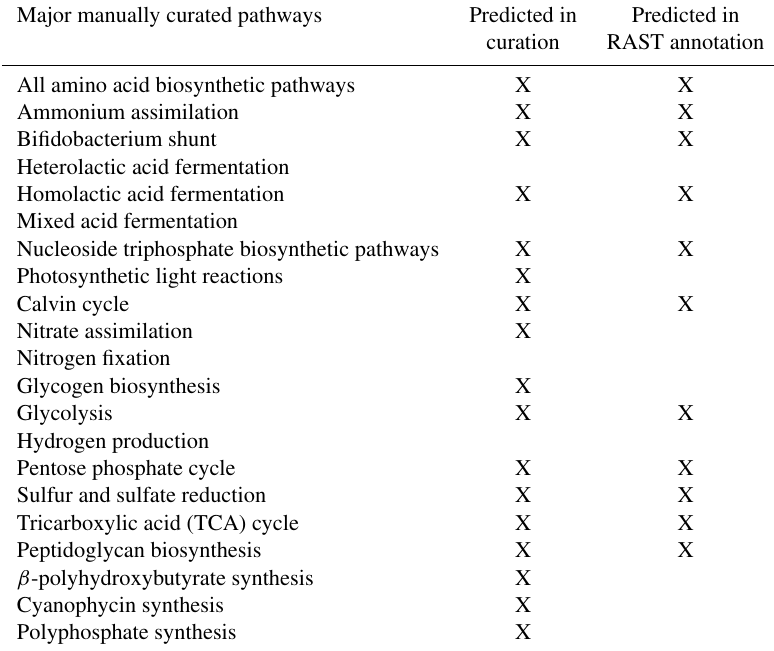
curation RAST annotation